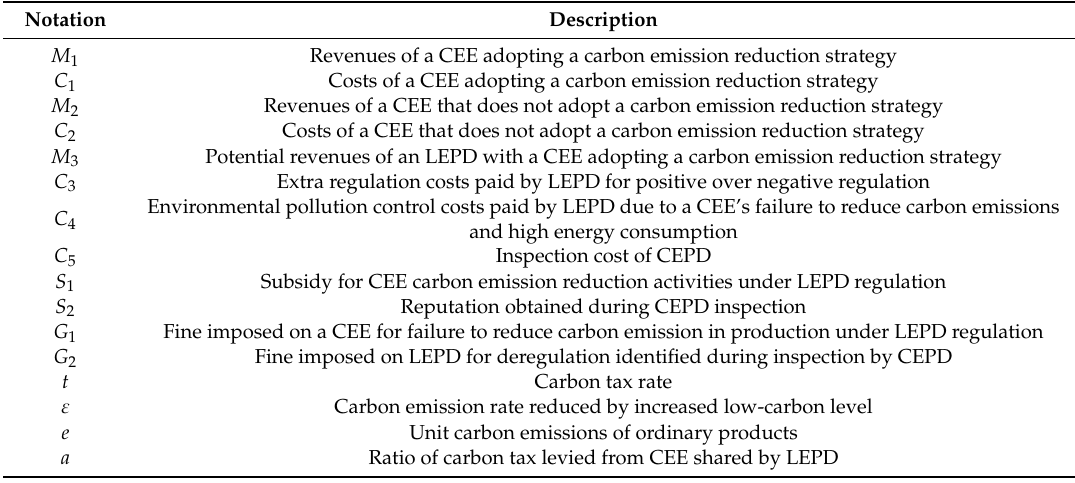
Table 1. Descriptions of notations. CEE, carbon emission enterprise; LEPD, local environmental protection department; CEPD, central environmental protection department.